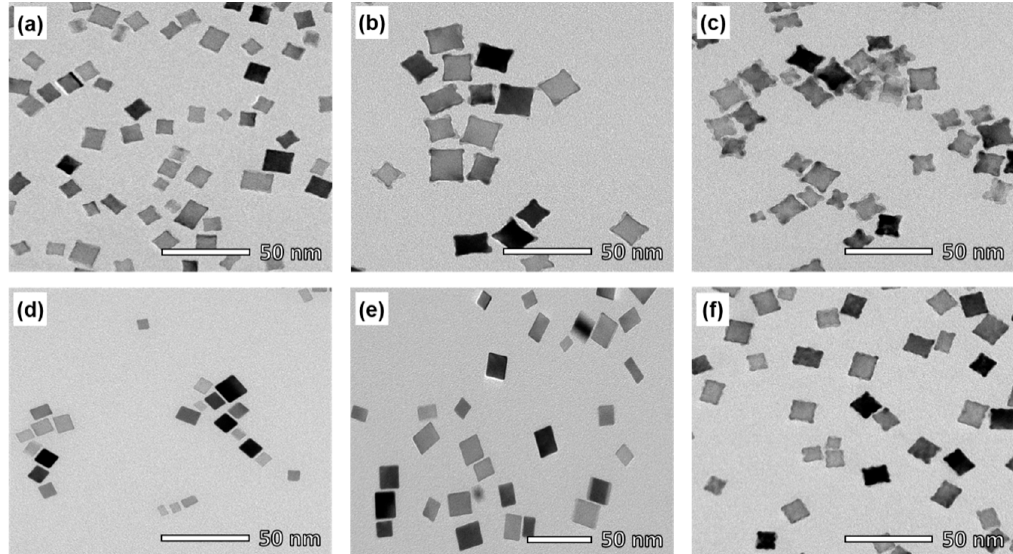
Figure 1. TEM images of ( a ) Pd@Pt core–shell nanocubes with a partial Pt shell (P-PdPt 0.6 ), ( b ) P-PdPt 4.5 , ( c ) P-PdPt 13 , ( d ) Pd@Pt core–shell nanocubes with a full Pt shell (F-PdPt 0.6 ), ( e ) F-PdPt 4.5 , and ( f ) F-PdPt 13 .